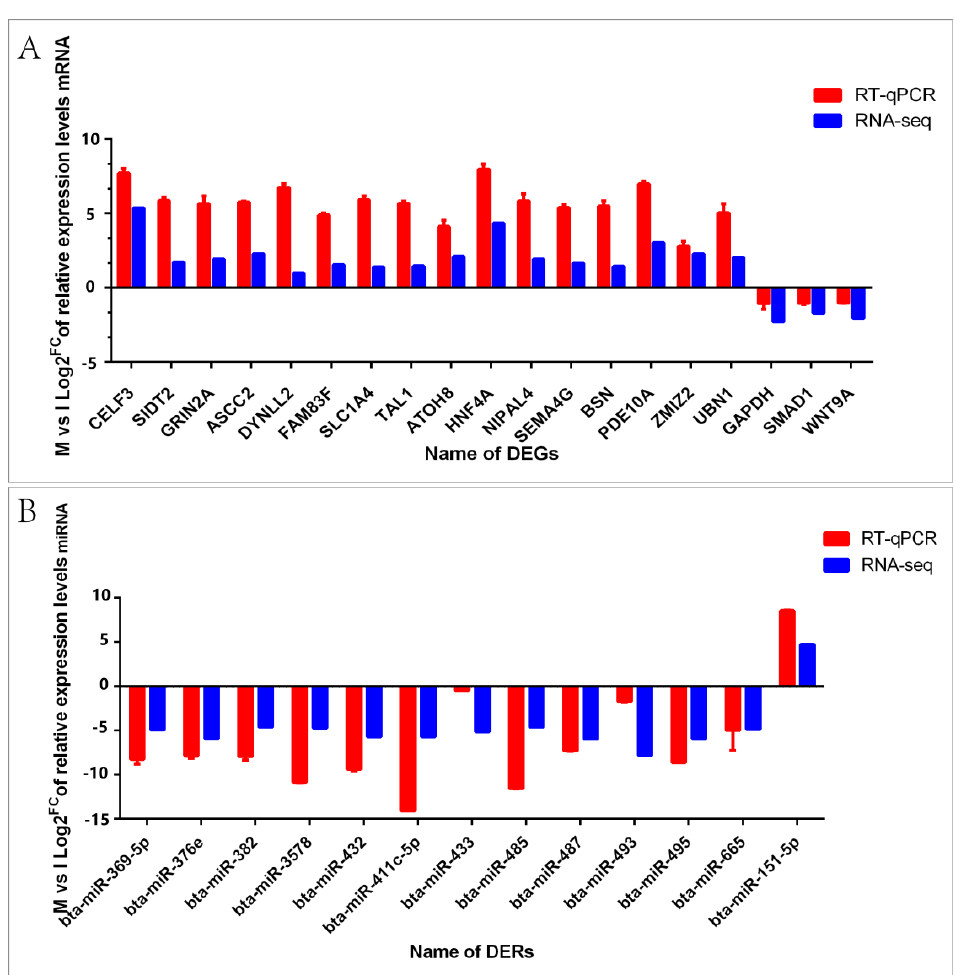
Figure 6. Fold change comparative analysis between real-time PCR result and sequencing data of DEGs and DERs. ( A ) The fold change of DEG expression levels; ( B ) The fold change of DER expression levels.